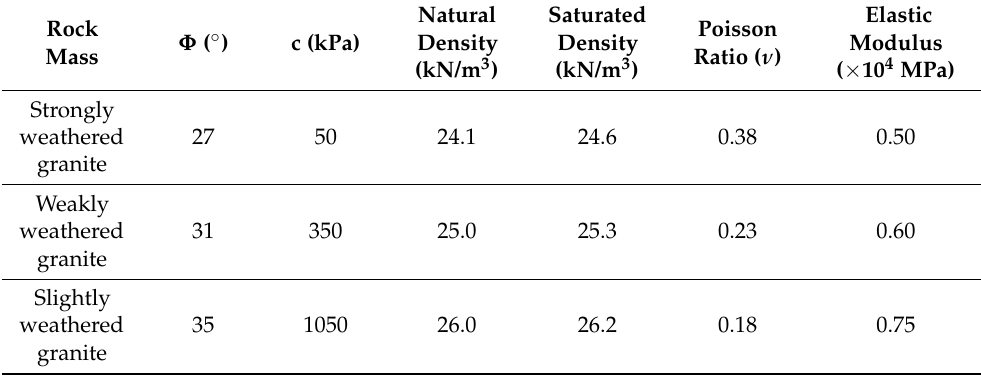
Figure 11. Numerical model of the excavated slope. ( a ) Numerical model. ( b ) Calculation section. ( c ) Monitoring points. Table 2. Physical and mechanical parameters of rock mass.